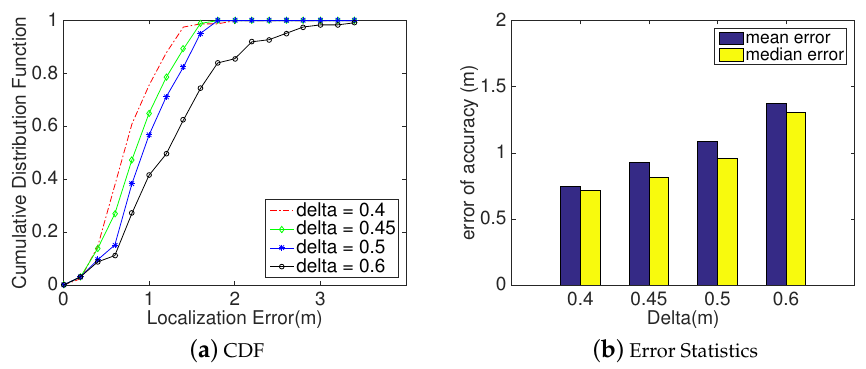
Figure 13. SITE ’s Device Localization Accuracy measured against different values of δ 1 . ( a ) Plot CDF of localization error at different values. ( b ) Two statistical measurements of performance: mean error and median